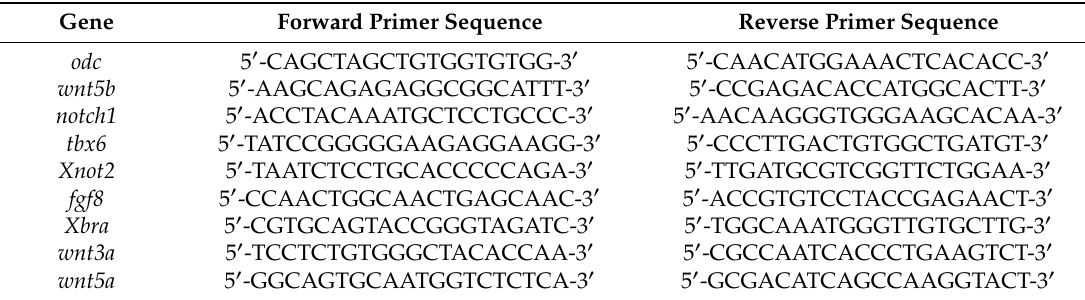
Table 1. List of Primers for